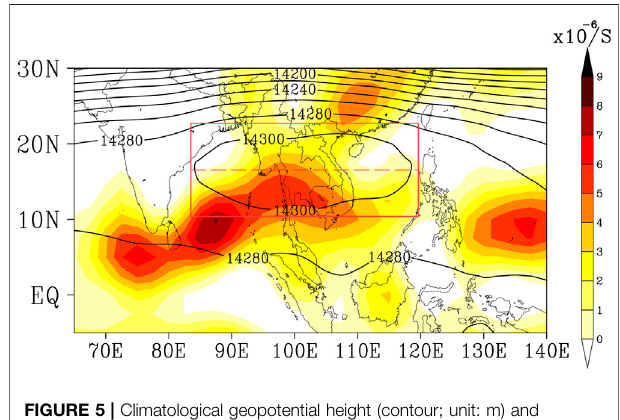
FIGURE 5 | Climatological geopotential height (contour; unit: m) and divergence (shaded; unit: s − 1 ) in May at 150 hPa from 1958 to 2018. Two regions (17.5 ° – 22.5 ° N, 82.5 ° E – 120 ° E and 10 ° – 15 ° N, 82.5 ° E – 120 ° E) are highlighted by red boxes, which were used to de fi ne the meridional displacement of the SAH.